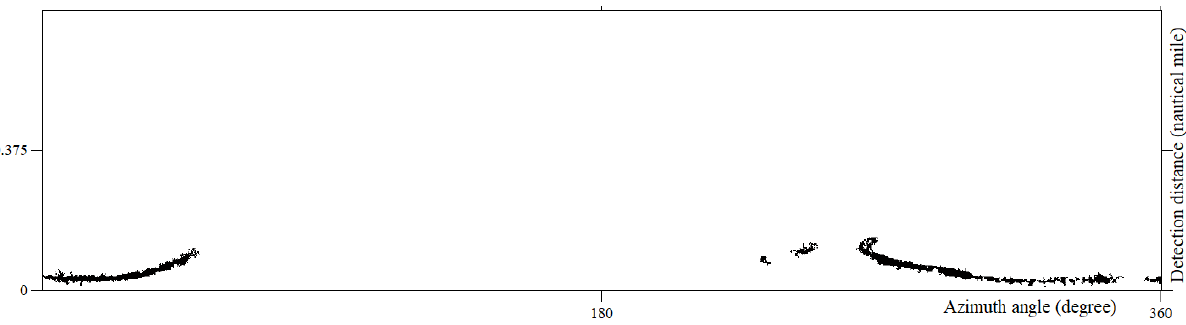
Figure 11. Oil films segmentation results in the polar coordinate system. The oil films were marked in red. 4. Discussion 4.1. Selection of Local Window Size Effective ocean wave monitoring regions calculated by different local window sizes of 32 × 32 pixels and 128 × 128 pixels were shown in Figure 12. Different time consumption was shown in Table 2. The small local window size mode consumes more calculation time. The computational efficiency improved as the local window size increased. So, a larger local window size should be recommended first for the application of emergency treat- ment sites. However, our method with the local window sizes of 32 × 32 pixels and 128 × 128 pixels contained invalid wave monitoring regions, which may lead to detecting false oil spill targets as in Figure 12a,b. Compared with these two local window sizes, it was suggested that the combined application of 64 × 64 pixels local window size, GLCM, and SVM was more suitable for extracting the effective areas of ocean wave monitoring.